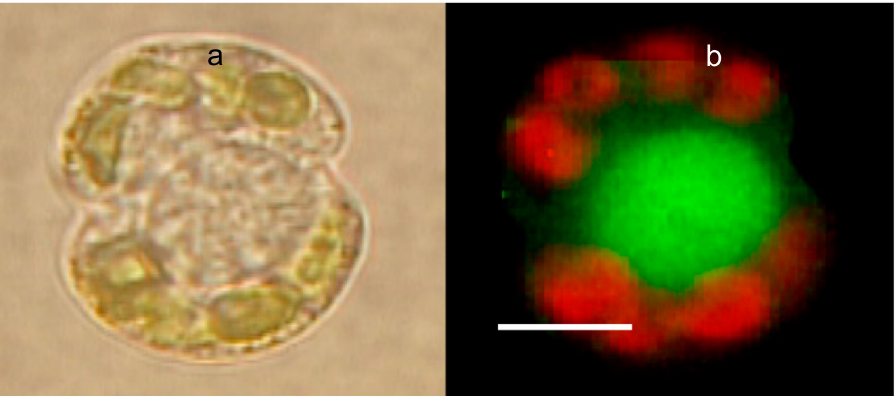
Figure 10. Phase contrast ( a ) and LysoSensor-labeled Karinia brevis ( b ). The red emission corresponds to the autofluorescence of Chlorophyll from Karenia’s chloroplasts. The green emission is from a large secretory granule, labeled with LysoSensor, a probe that binds specifically to secretory granules. Bar = 8 µ